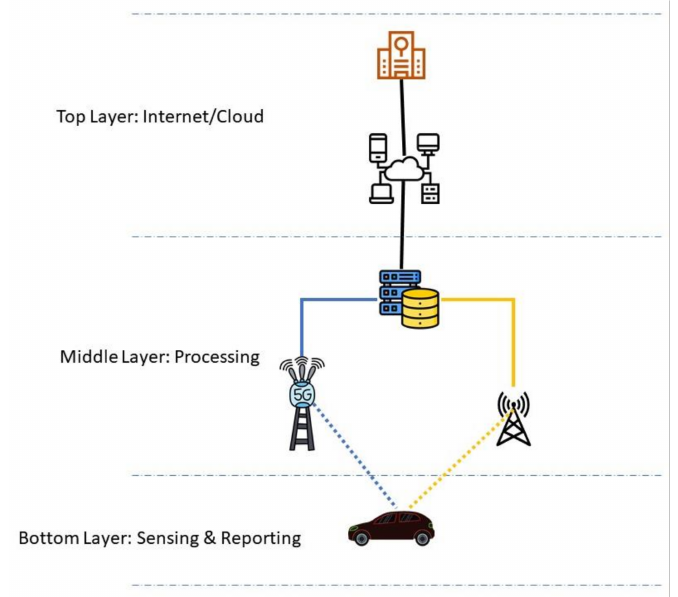
Figure 3. An overview of the proposed three-layer communication